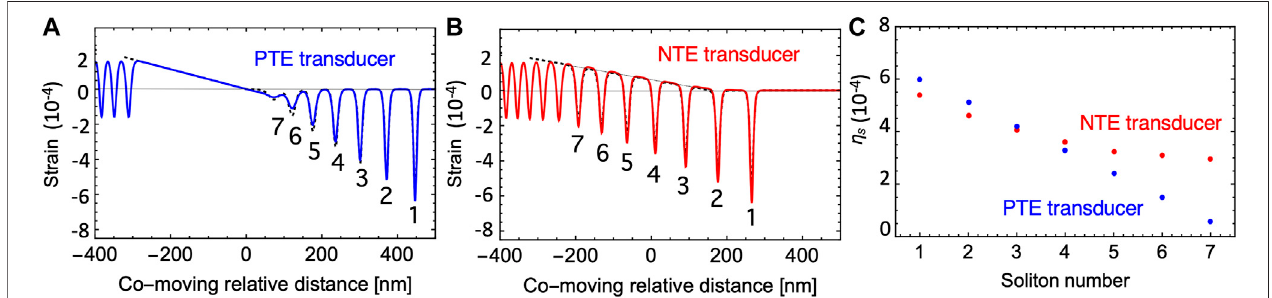
FIGURE 4 | Fits of the simulated strain pro fi le at t (cid:1) 80 ns and | η 0 | (cid:1) 5.75 × 10 – 4 to isolated solitons on a linear background for the case of (A) a PTE transducer and (B) a NTE transducer. The material-speci fi c parameter w was held fi xed according to the parameters of the simulation at 0.14324 nm appropriate to sapphire 100 longitudinal propagation. (C) shows the distribution of strain over the solitons for each